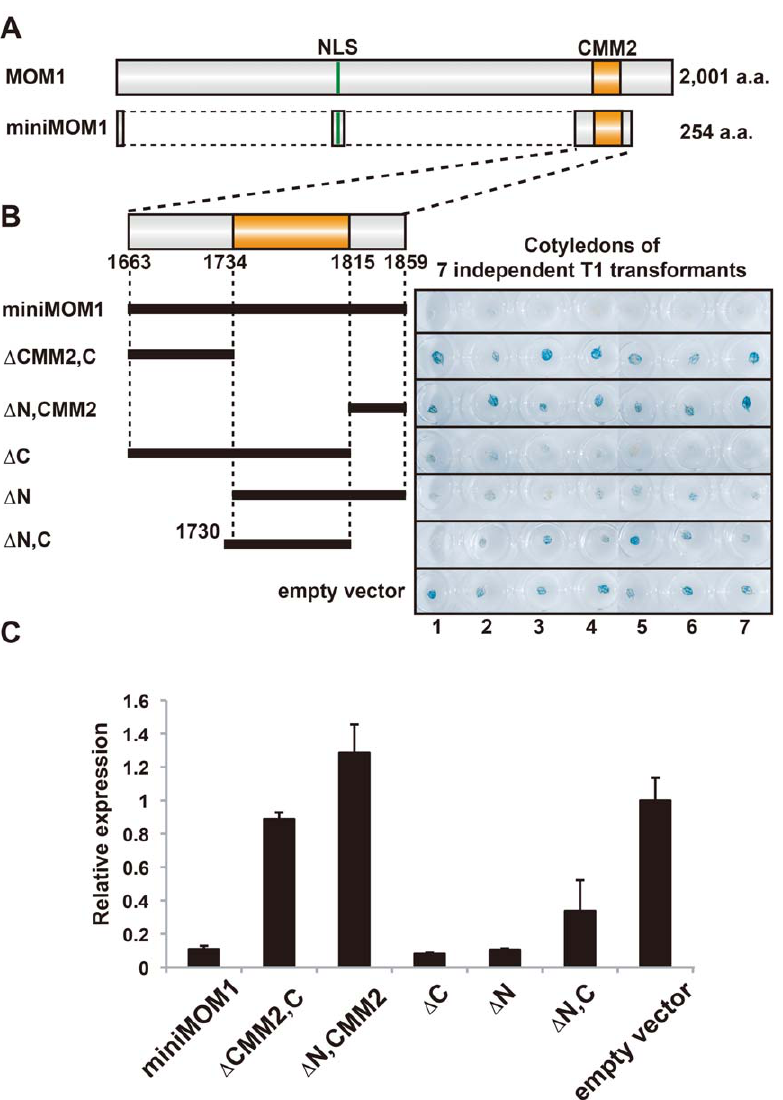
Figure 1. CMM2 is necessary and sufficient for the TGS activity of MOM1. (A) Schematic representation for MOM1 and miniMOM1. (B) Left , deletion derivatives of miniMOM1 that were introduced to mom1 L5 plants harboring a transgenic L5 locus encoding ß-glucuronidase [25]. Right , histochemical GUS staining of cotyledons of seven independent 1-week-old T1 transgenic plants transformed with the corresponding miniMOM1 deletion derivatives. The ‘‘empty vector’’ control corresponds to mom1 L5 transformed with a vector construct without miniMOM1 sequences. (C) Relative levels of GUS mRNA in T2 plants from 3 independent T1 plants determined by quantitative RT-PCR and normalized to 18S rRNA. The mean of the ‘‘empty vector’’ control was set to 1. Error bars represent S.E. calculated from 3 experimental sets of 40 to 50 plants